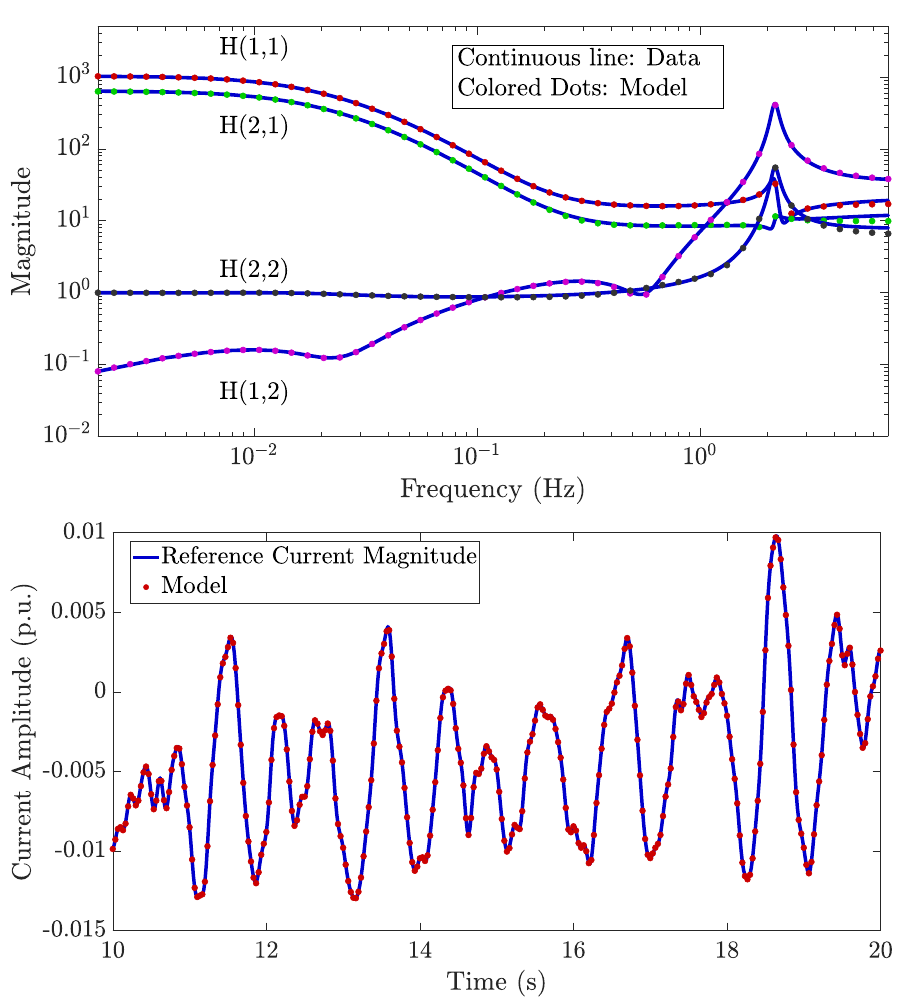
Figure 4. Noise-free generator model extraction. Top panel : frequency domain validation of the generator model (order N = 9) against exact machine equations. Bottom panel : the time domain validation of the model against the current magnitude reference